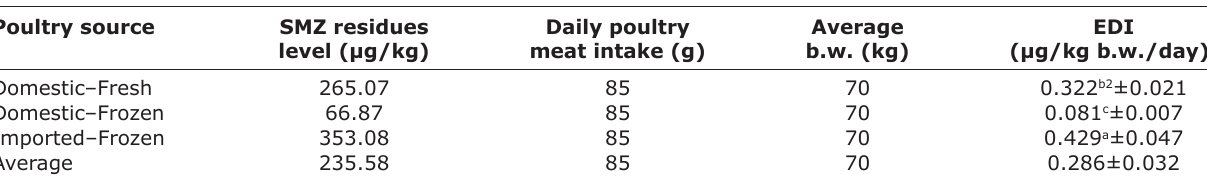
Table-3: EDI of SMZ by Jordanian